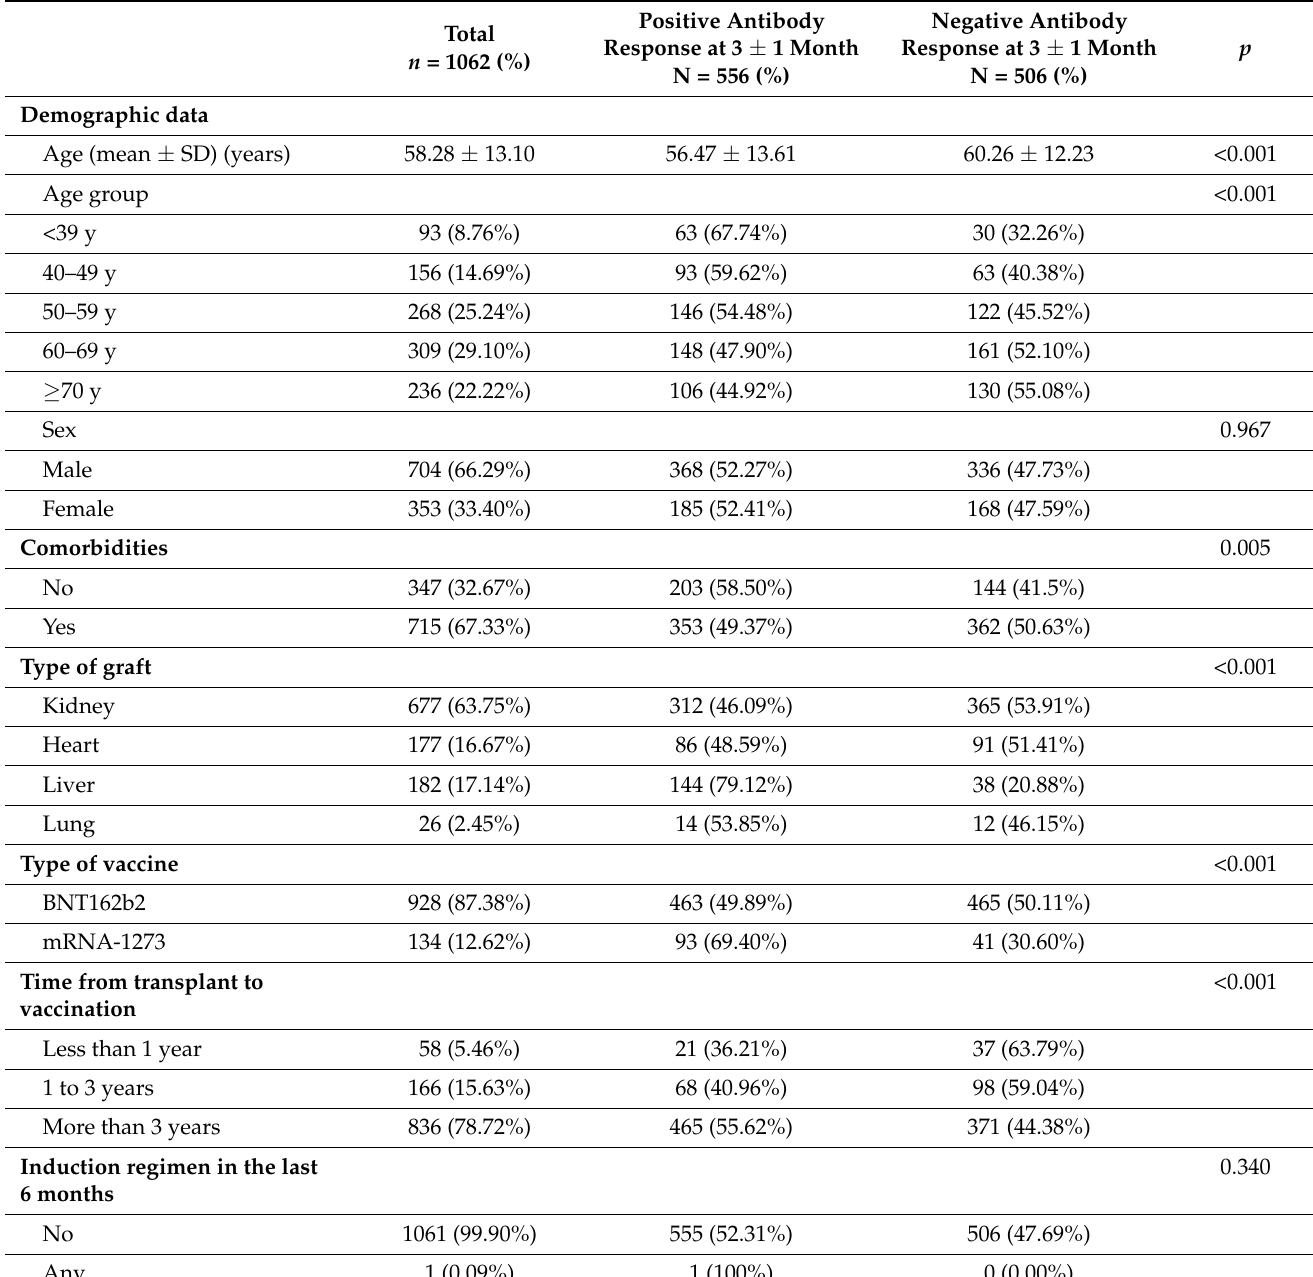
Table 1. General characteristics of study